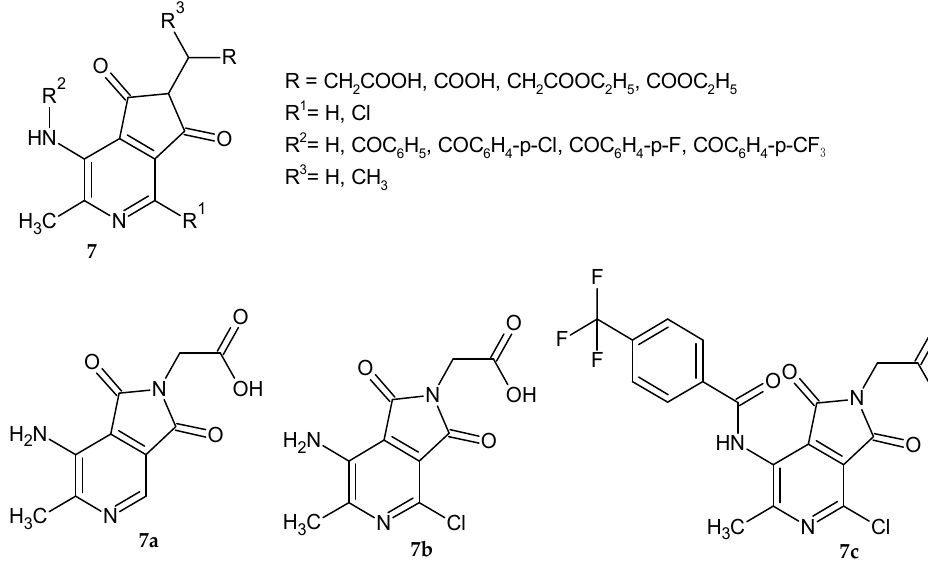
Figure 4. 6-Methyl-pyrrolo[3,4- c ]pyridine-1,3-dione derivatives 7 as aldose reductase inhibitors and Figure 4. 6 ‐ Methyl ‐ pyrrolo[3,4 ‐ c ]pyridine ‐ 1,3 ‐ dione derivatives 7 as aldose reductase inhibitors the most active derivatives 7a – c and the most active derivatives 7a – c .